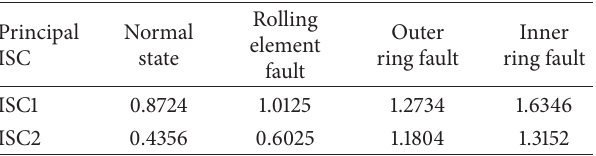
Table 2: Permutation entropy of the first two ISCs of the three sig-